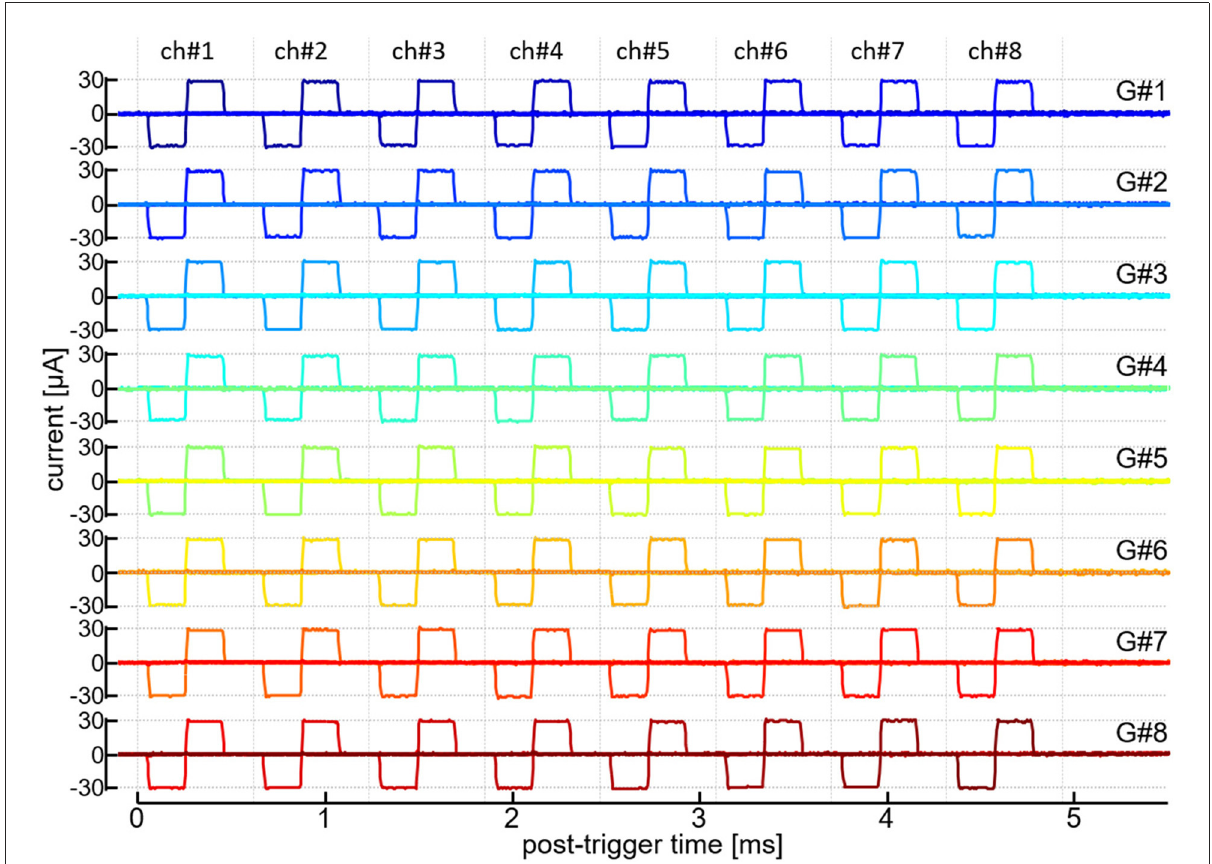
FIGURE3 Time-division semi-parallel mode of stimulus outputs. Recorded traces of the output current pulses from 64 output channels are shown on the same timeline axis. Labels in the rightmost, “G#1” to “G#8,” indicate the current generators in operation. Labels in the uppermost, “ch#1” to “ch#8,” indicate the output channels of every current